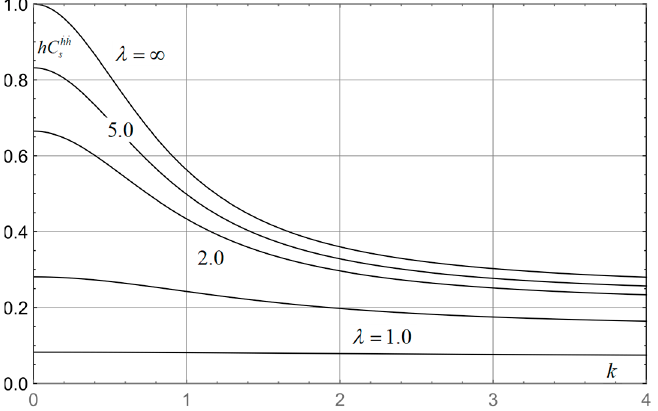
=   . . . . =   =   with respect to h h h h = C with respect to with respect to s with respect to speed t